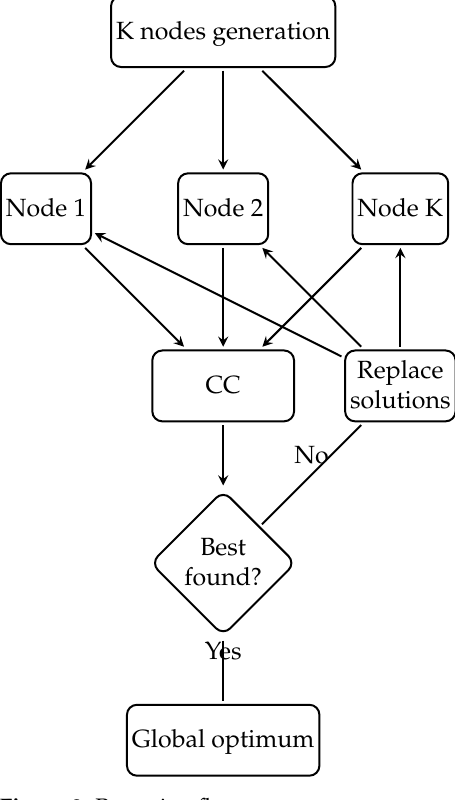
Figure 2. Procesing